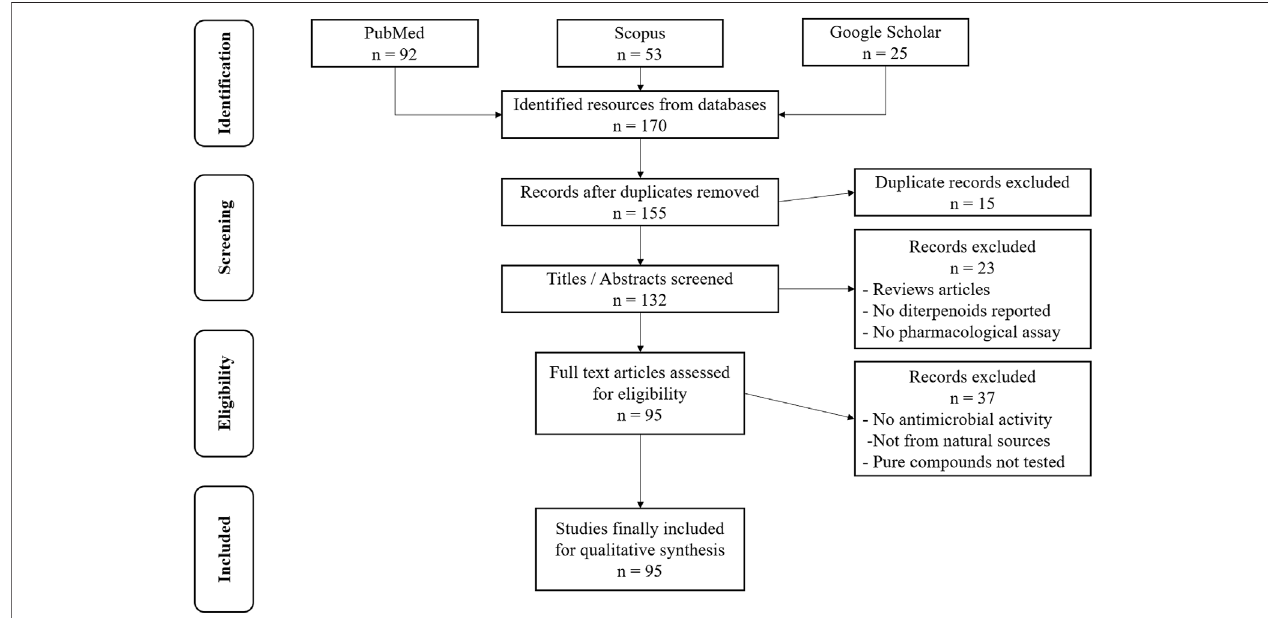
FIGURE 1 | The PRISMA fl ow diagram for article